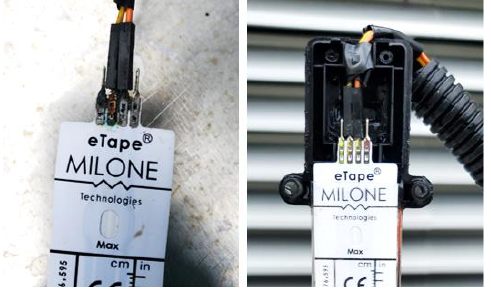
Figure 7. Corroded pins of the sensor ( left ) and sensor replaced ( right ).